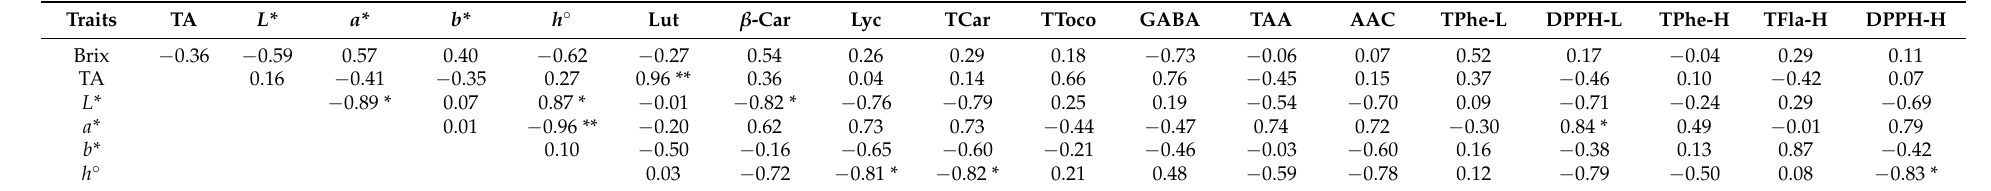
Table 4. Pearson’s correlation coefficients from physicochemical data, the contents of antioxidant constituents, and antioxidant activities of six medium-sized tomato